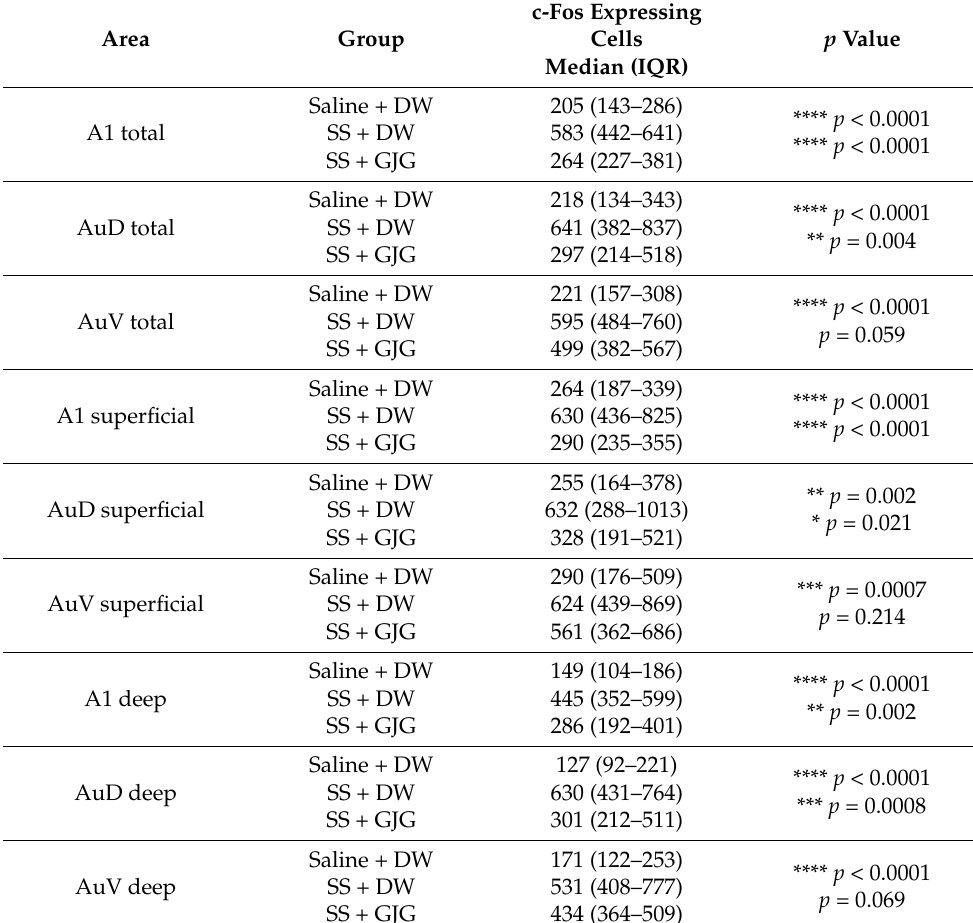
Table 2. Effect of goshajinkigan (GJG) administration on c-Fos expression in the auditory cortex of salicylate-treated